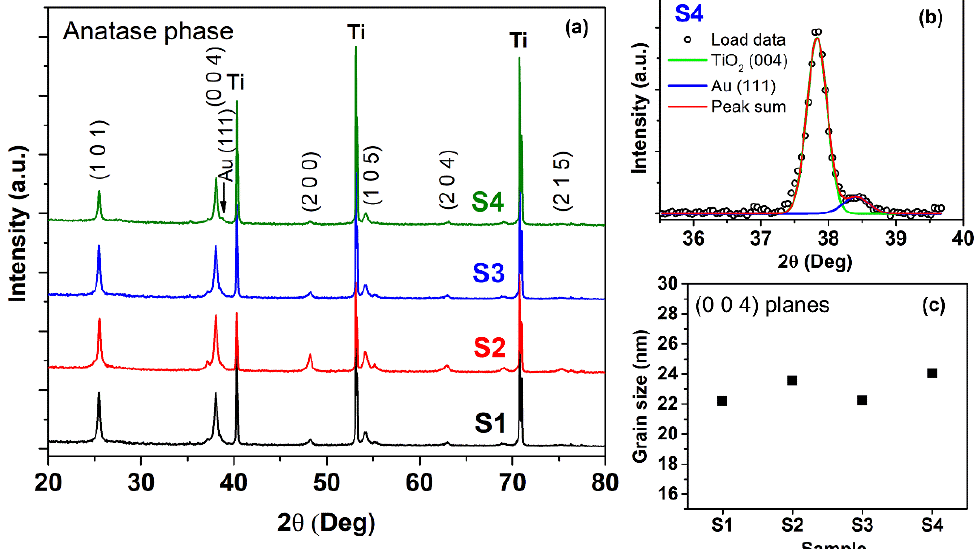
Figure 2. ( a ) The XRD patterns of TNWs/TNAs (S 1 ), Au NPs-TNWs/TNAs (S 2 ), Au NRs- TNWs/TNAs (S 3 ), and Au NPs-NRs-TNWs/TNAs (S 4 ). ( b ) The (004) peak of S 4 shows two compo- nents of TiO 2 (004) and Au (111). ( c ) The estimated grain size of the four nanomaterials.